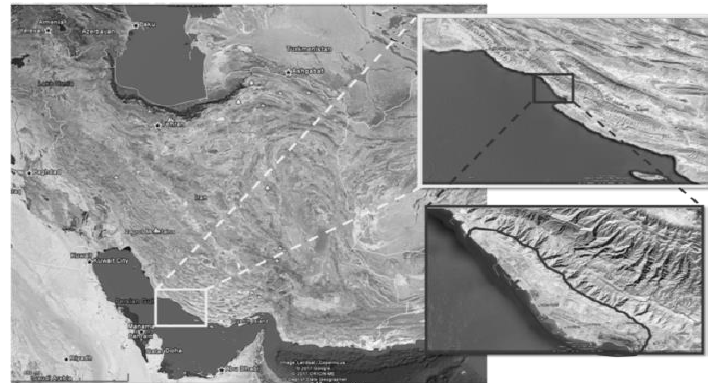
Figure 1. South Pars Zone on the map- the area with the red line is the area of